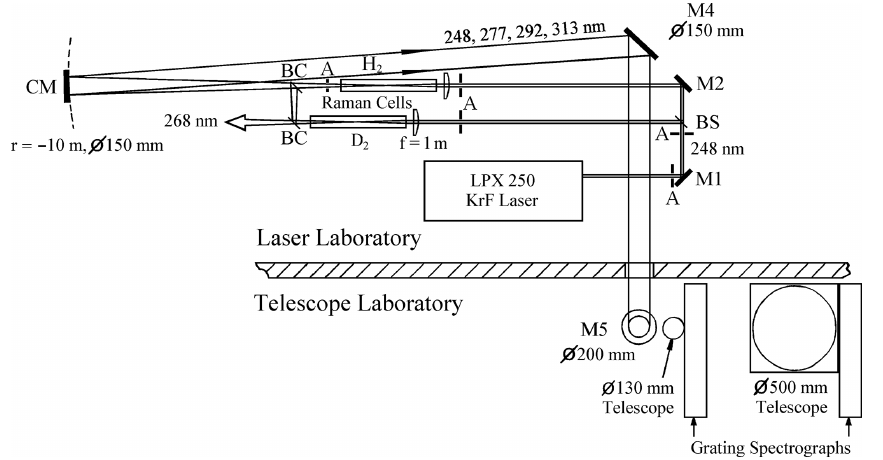
Figure 1. Overview of the IFU stationary ozone DIAL system; the system covers two separate laboratories for the laser and the telescopes. Abbreviations are as follows. M1, M2: dielectric high-reflecting mirrors for 248nm; SM: spherical mirror (M3), high-reflecting for 248 to 313nm, f = 5m; M4, M5: dielectric mirrors, high-reflecting for 248 to 313nm; BS: 50% beam splitter; BC: wavelength-selective beam combiner, reflecting 99% at 292nm for an incidence angle of 45 ◦ and transmitting all the other lidar wavelengths with losses not exceeding 12%. A: rectangular sand-blasted aluminium apertures for blocking divergent parts of the amplifier emission that would otherwise hit and evaporate the black surfaces of the optics holders, leading to more rapid ageing of the optics. Table 1. Transmitter details (the numbers are given for normal operating